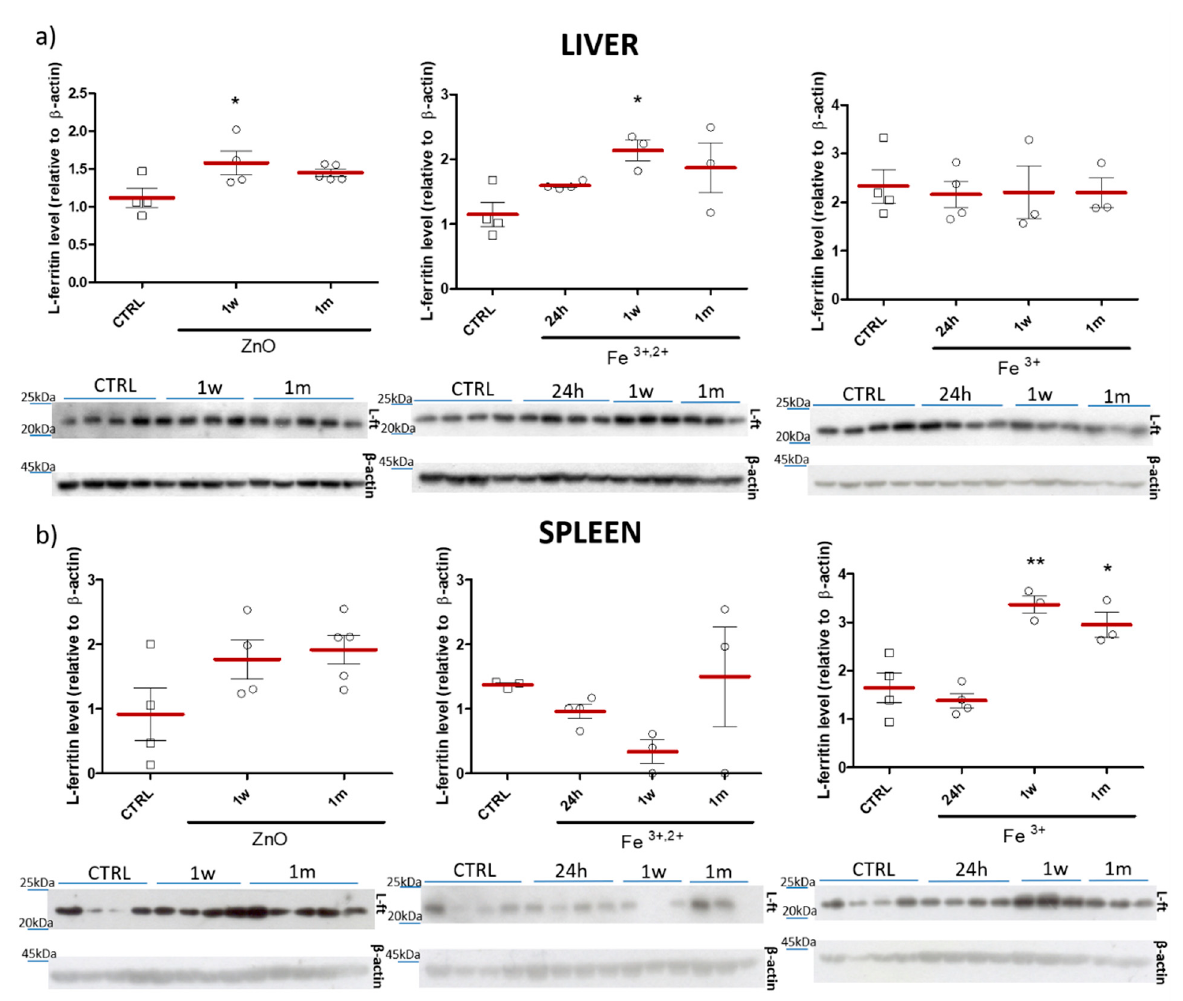
Figure 11. Western blot densitometric analyses of the levels of L-ferritin subunit in the liver ( a ) and spleen ( b ). Representative immunoblots are shown below plots. Results obtained 24 h, 1 w or 1 m after intra-gastric administration